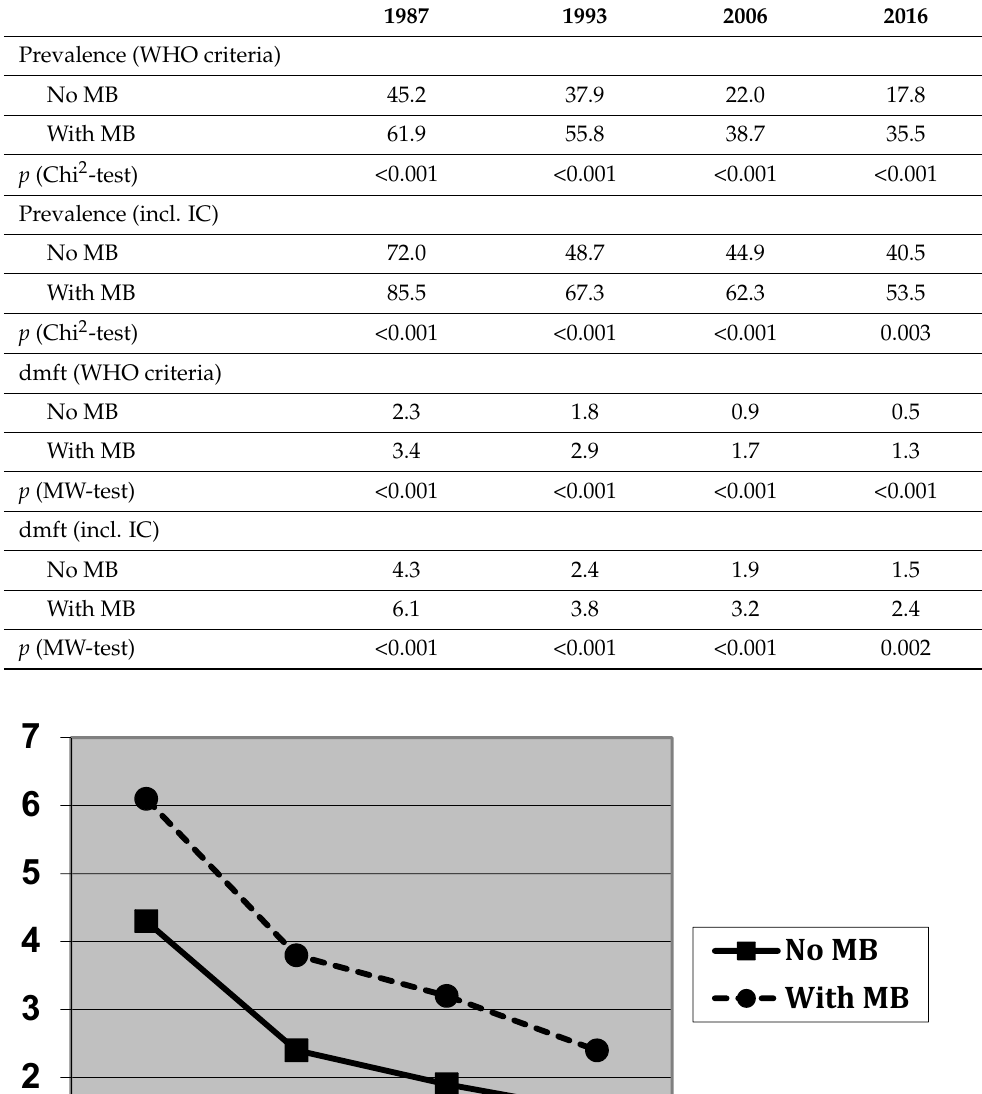
Table 3. Caries prevalence and dmft-values (both according to WHO criteria and including ini- tial caries, IC) in preschool children in Hamburg 1977–2016, related to the children’s migration background (MB).